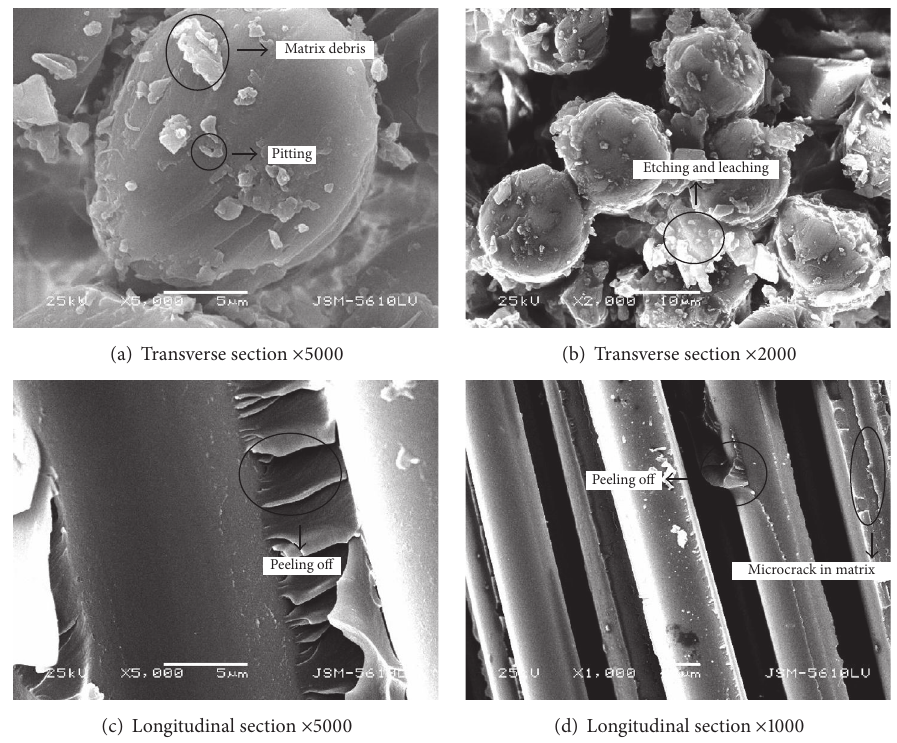
Figure 3: Microstructure morphology of GFRP bars embedded in concrete in the standard-curing environment.